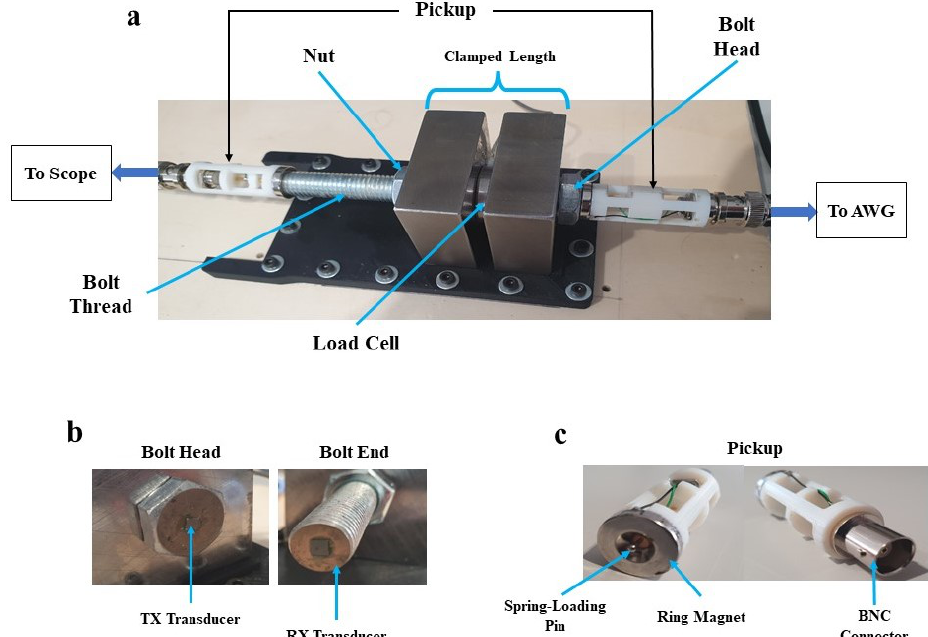
Figure 15. ( a ) Experimental setup of the ultrasonic testing of a bolted joint. ( b ) Transmitter and receiver transducers attached to bolt head and end, respectively. ( c ) The pickup unit with BNC and spring-loading pin connectors.